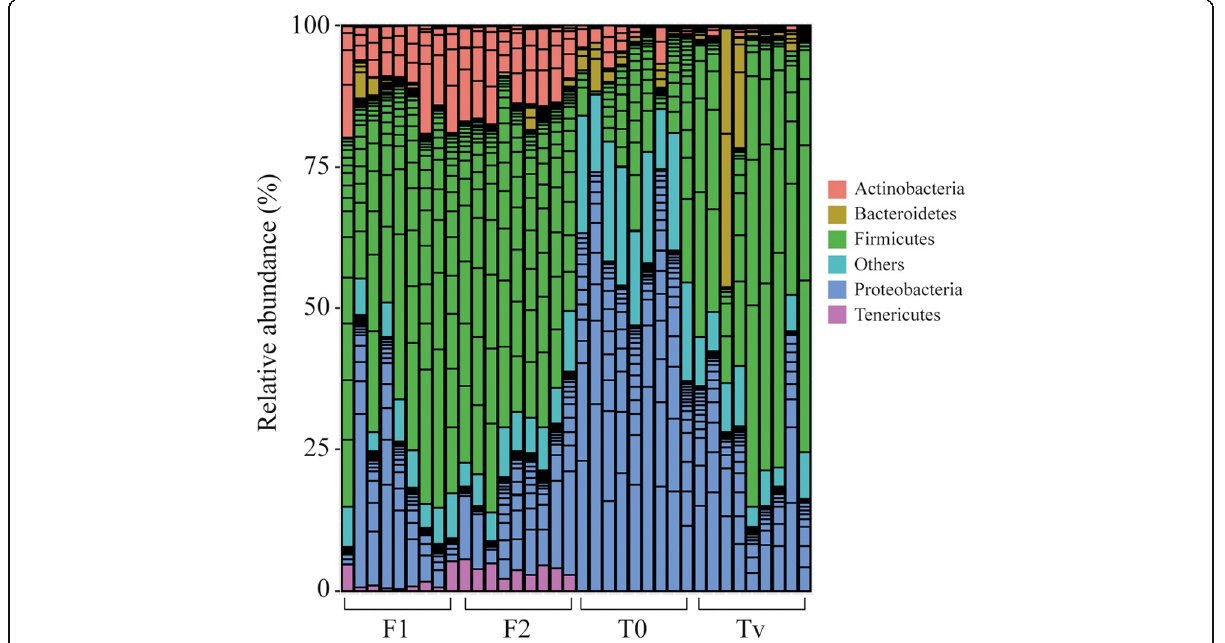
Fig. 4 Relative abundance (%) of the overall most prevalent bacterial phyla of the gut of rainbow trout fed different